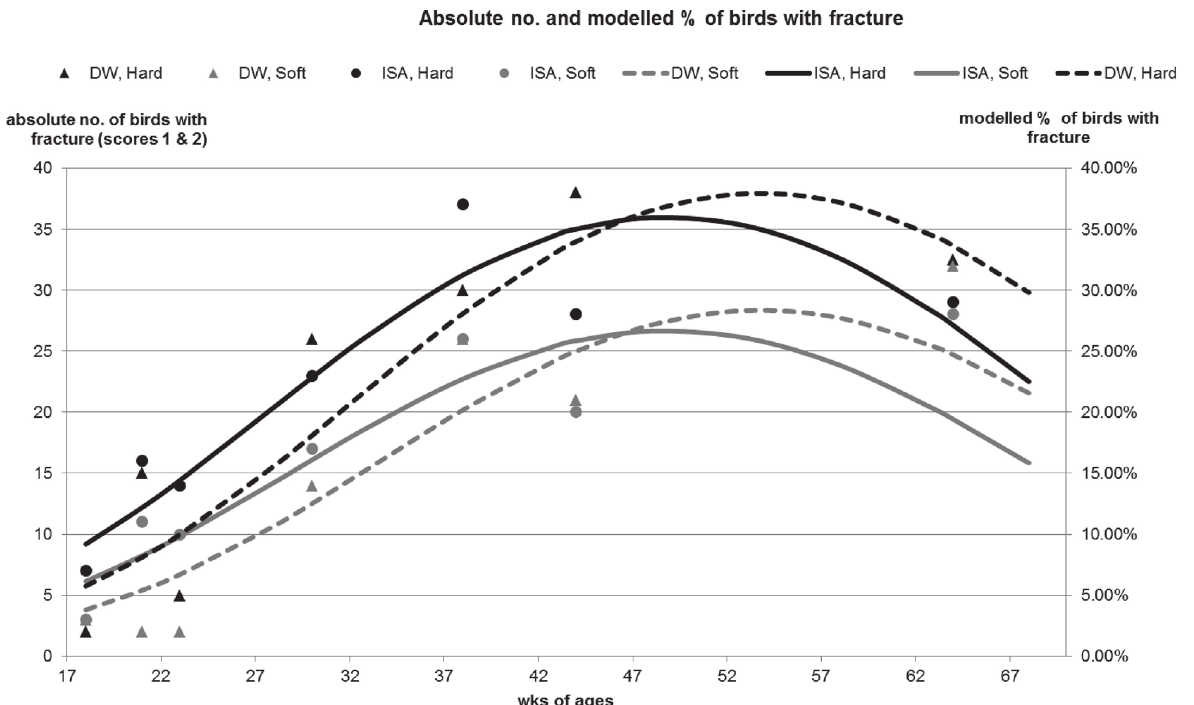
Fig 3. Fractured keel bones. Absolute numbers and modelled % of birds with a fractured keel bone over the course of the experiment for each of the four perch type by genetic line combinations.